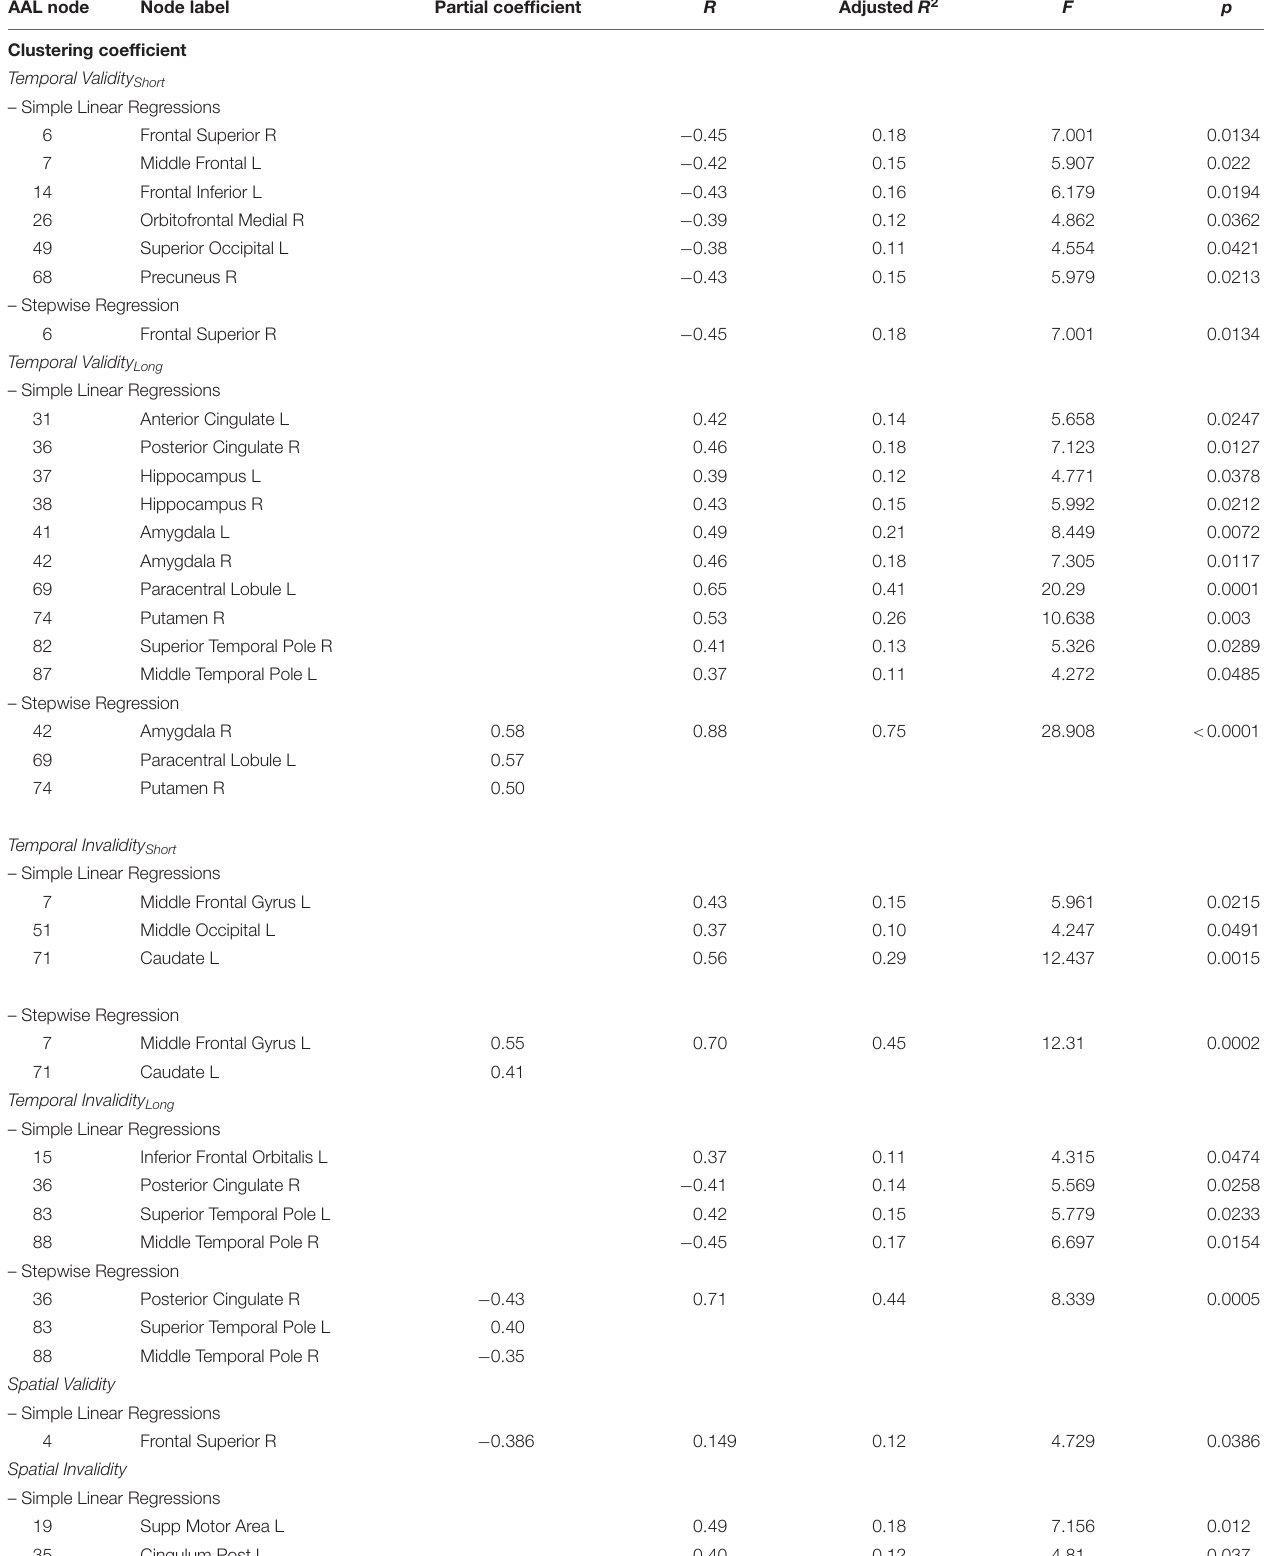
TABLE 3 | Observed covariance between clustering coefficient and spatio-temporal predictive performance. AAL